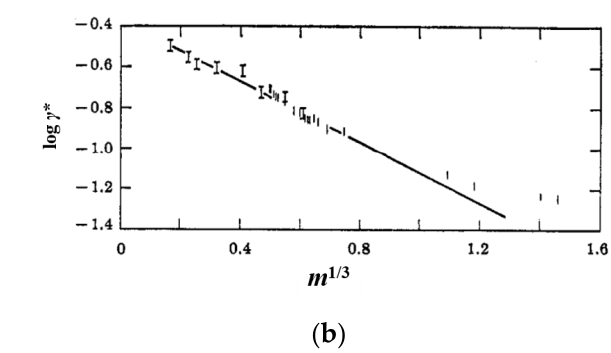
Figure 2. ( a ) Typical isopiestic apparatus constructed from a vacuum desiccator. ( b ) Cube-root plot of the mean activity coefficient obtained from isopiestic ( ∣ ) and EMF (I) measurements. Note that γ * = ( i / s ) γ , where i / s is the polymer charge fraction. Reproduced with permission [40] . Copyright 1967, American Chemical Society.